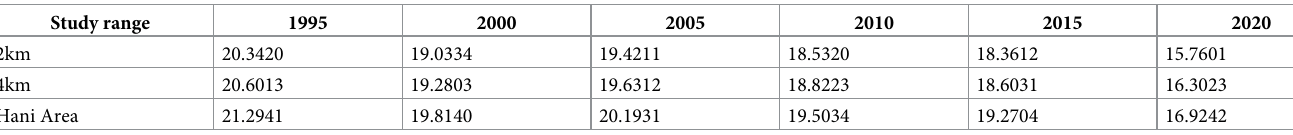
lower sustainable development ability. For a long time, the Hani people used terraced fields as the main mode of cultivation due to special geographical conditions and traffic inconveniences [54]. Hani’s terraced fields provide the basic conditions for the survival and development of Hani people and are a reasonable means of communication with the environment formed by Hani people for a long time. However, due to economic development and population growth, the problem of more people and less land is becoming more and more acute. In the Hani inhabited areas, the Hani people develop the forest land near the ethnic village into cropland, and the planting of Hani terraces has reached the limit, leading to the intensification of land- scape fragmentation and the reduction of ecosystem services provided by the forest land. The reduction in ecosystem services leads to a decrease in ecosystem regulation, which could lead to additional ecological problems. The plight of more people and less land has also brought Table 4. Change of the average values of resistance in three gradients.